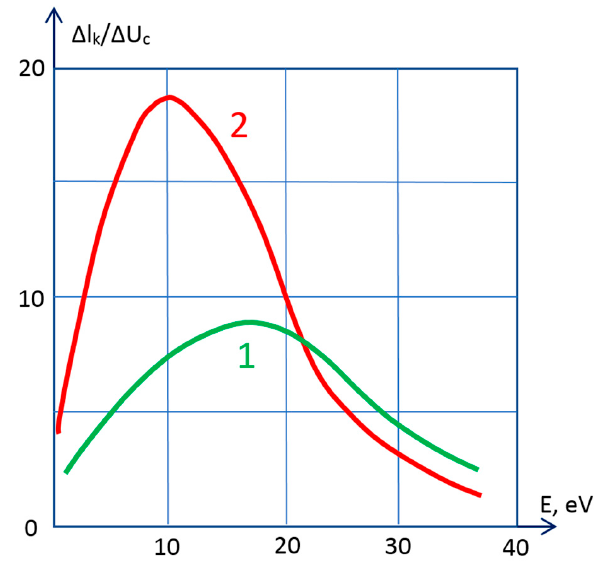
Figure 5. Energy distribution of carbon ions. 1—anode current of 70 A, 2—anode current of 120 A.